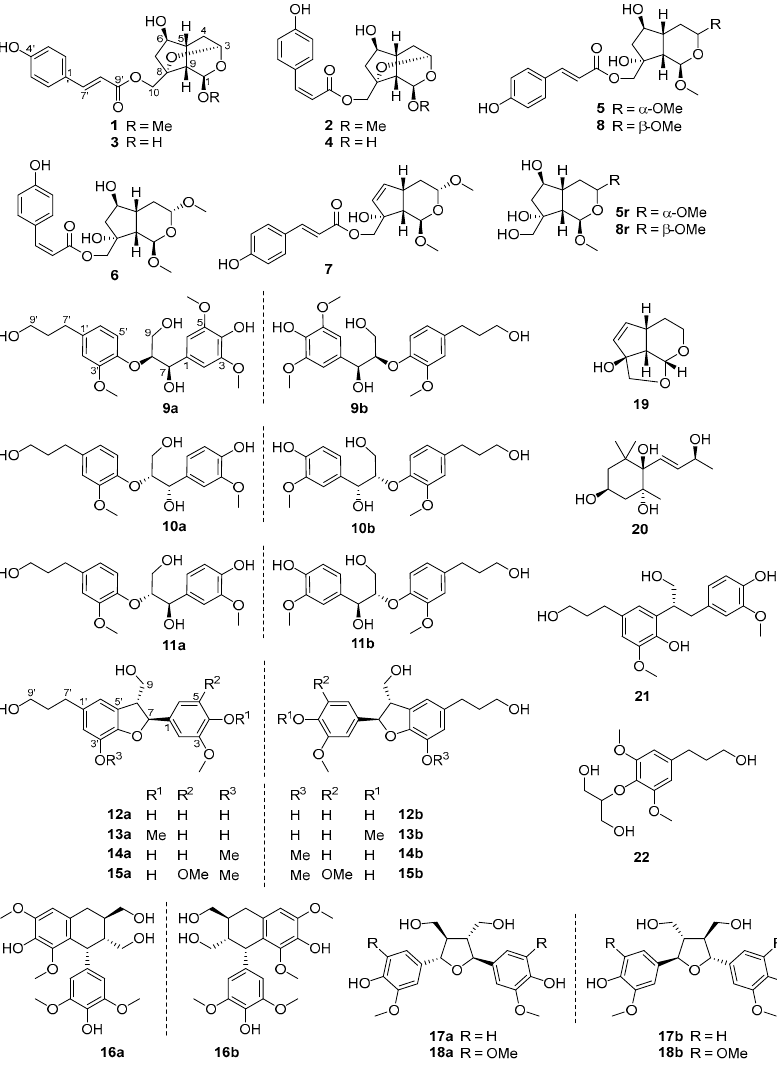
Figure 1. Structures of the chemical constituents from V. bracteatum .